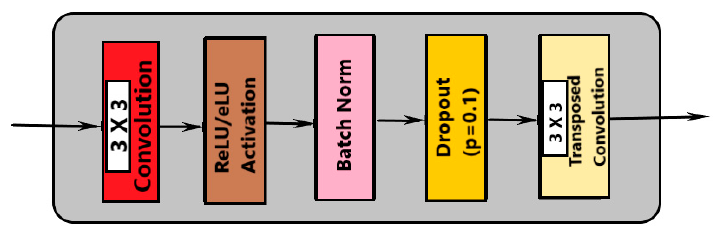
Figure 6. Operations in each layer of the expansion path.